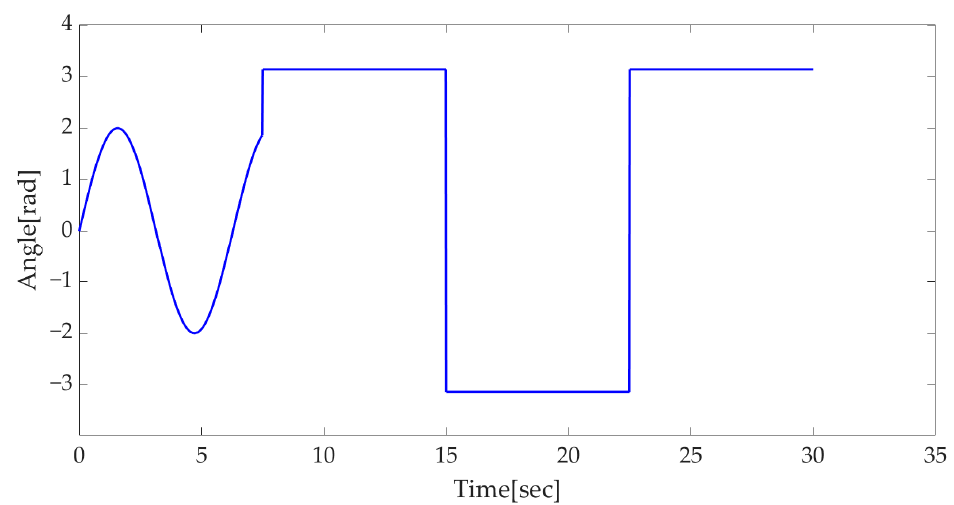
Figure 6. Mixed control input.